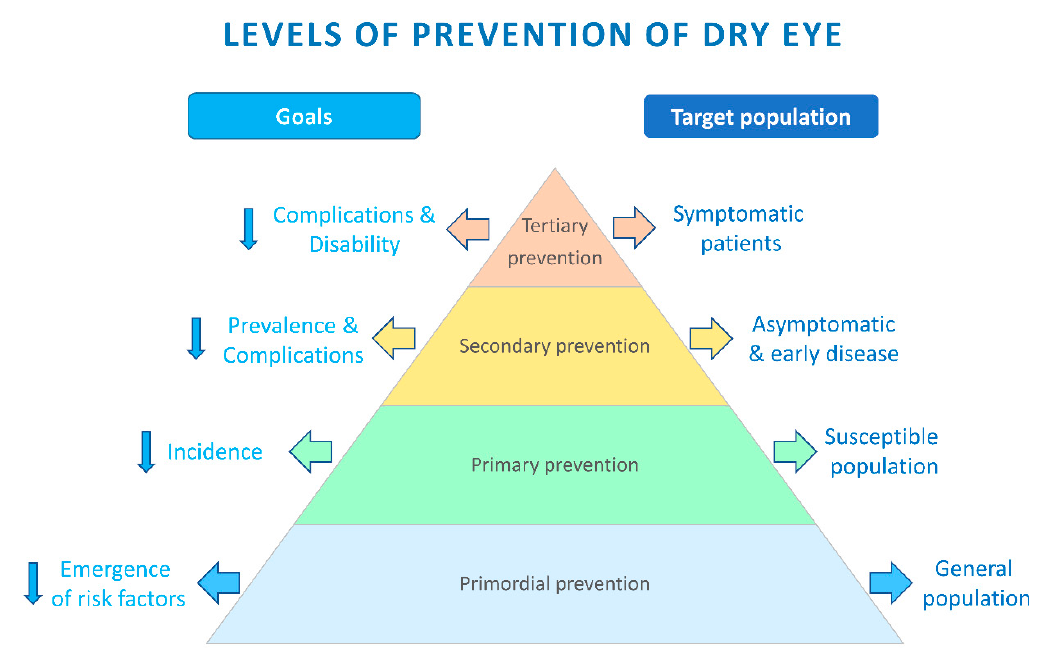
Figure 1. Tiers of prevention of dry eye disease (DED): this figure describes the pyramid depicting the preventive strategies at various levels of health care with the goals (arrows on the left) and the target population (arrows on the right).